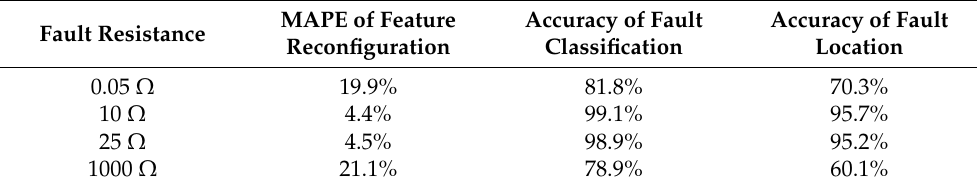
Table 2. Comparison results with different fault resistance.